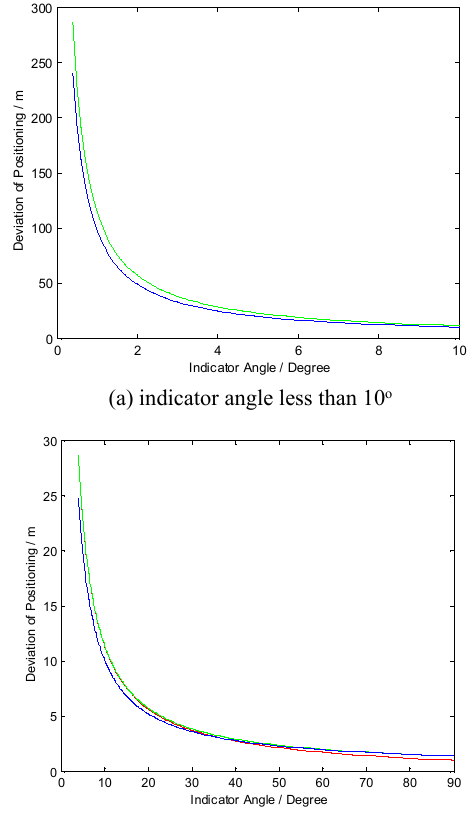
Fig 3. Positioning errors changing with indicator angles.